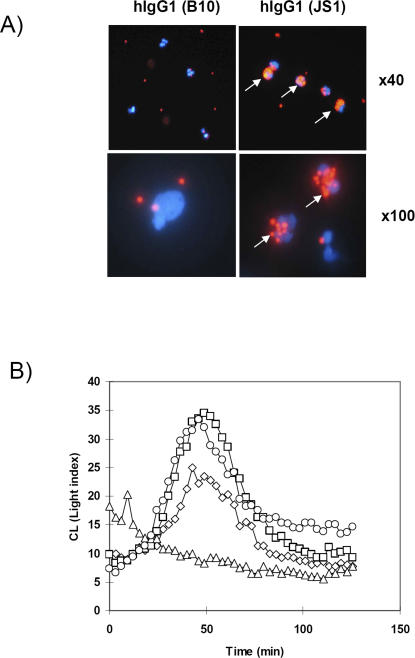
JS1 and JS2 Are Fully Functional Human Antibodies(A) Human neutrophil-mediated phagocytosis of GST-PfMSP119 coated fluorescent 1-μm microspheres by JS1. A control human IgG1 recognizing the homologous GST-MSP119 from P. yoelii was unable to opsonize beads and no ingestion was observed. Phagocytosed beads (red) were visualized in the cytoplasm of neutrophils (arrowed) whose nuclear DNA was counterstained in blue by DAPI.(B) Stimulation of neutrophil NADPH oxidative bursts using JS1 and JS2 attached to GST-MSP119-coated microtiter plates. Chemiluminescence (CL; arbitary units) was induced by anti-PfMSP119 human IgG1 JS1 (⋄), JS2 (○), human IgA1 (□), or no antibody (▵). All antibodies at 1 × 10−7 M. Data are presented as mean arbitary units from duplicate wells with neutrophils from a single donor.